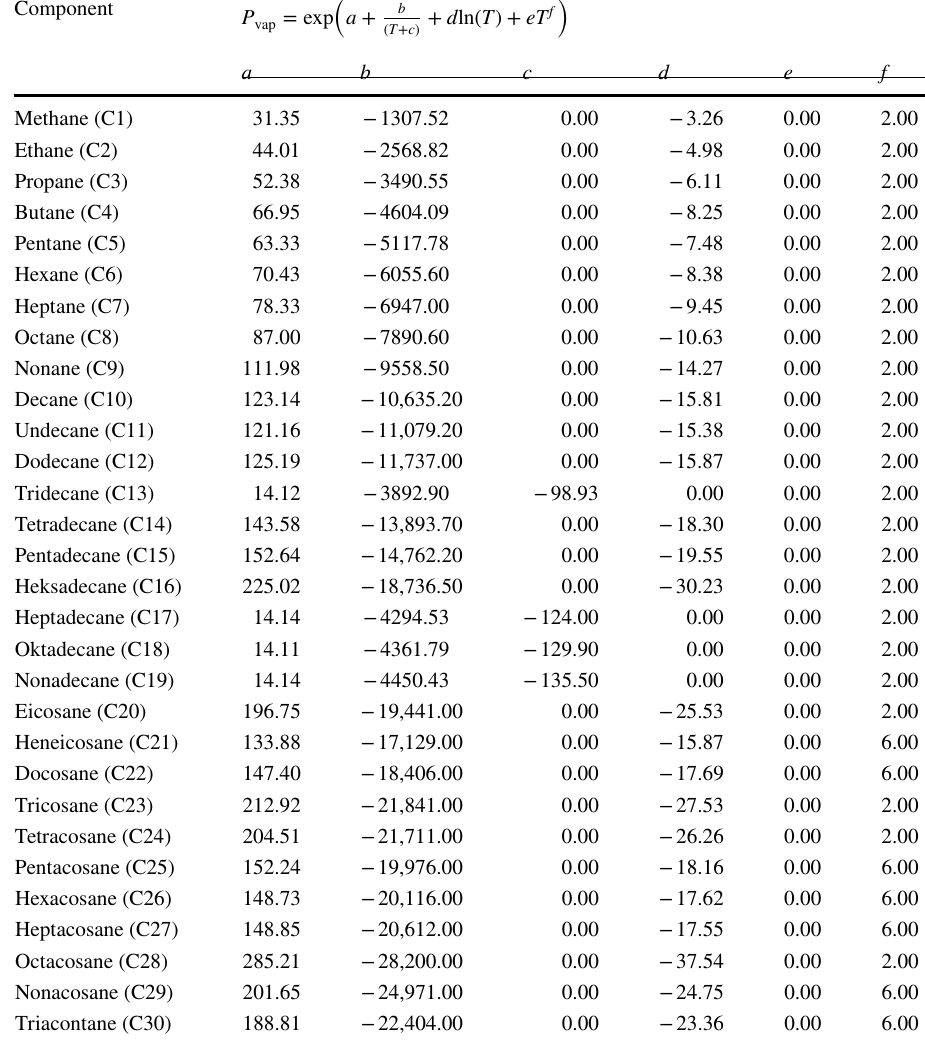
Table 5 Calculation procedure of bubble point ( T